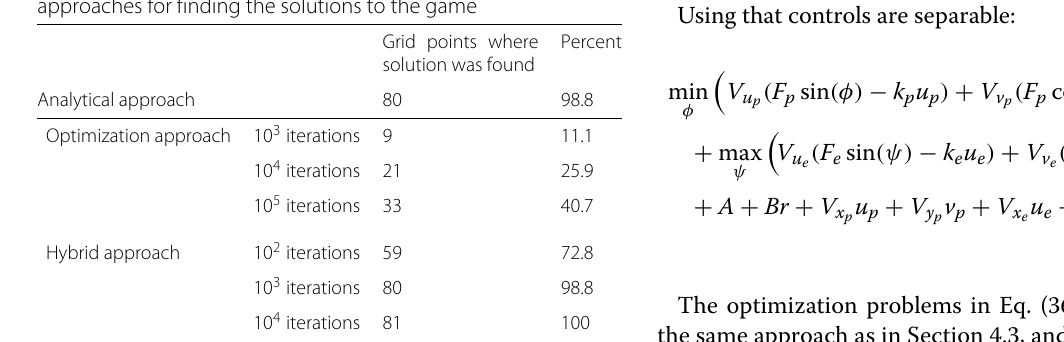
Table 1 Comparison of analytical, optimization, and hybrid approaches for finding the solutions to the game Analytical approach 80 98.8